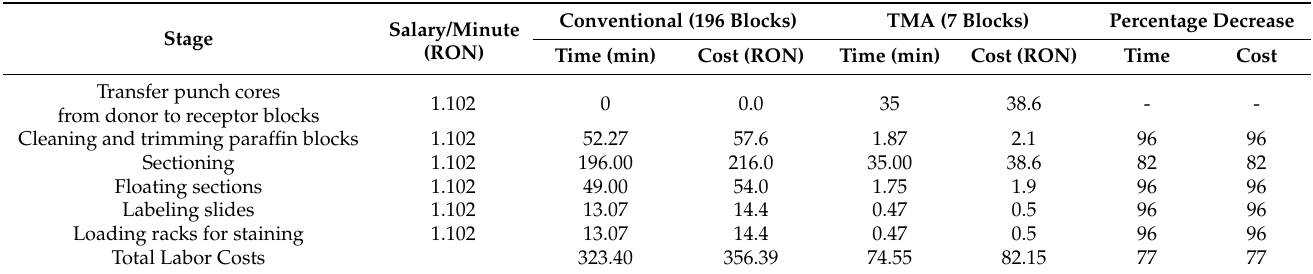
Table 1. Time and cost required for preparing conventional versus TMA blocks and slides. All prices are based on 2022 average salaries for histotechnologists in